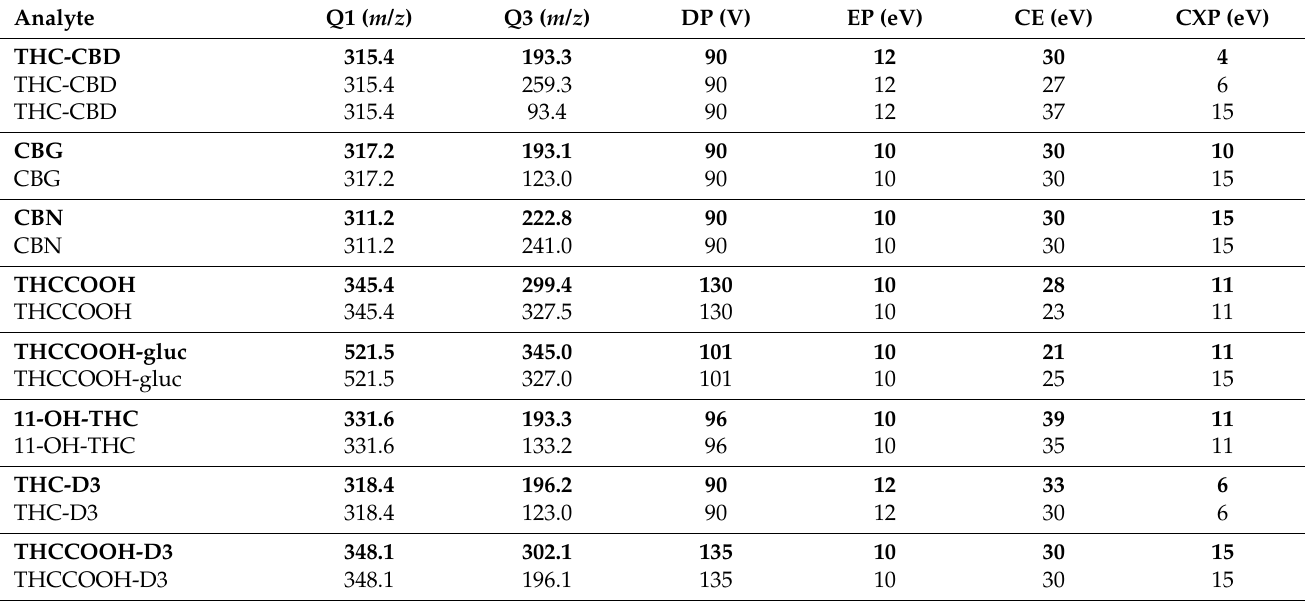
Table 4. MRM parameters. Quantifying transitions are marked in